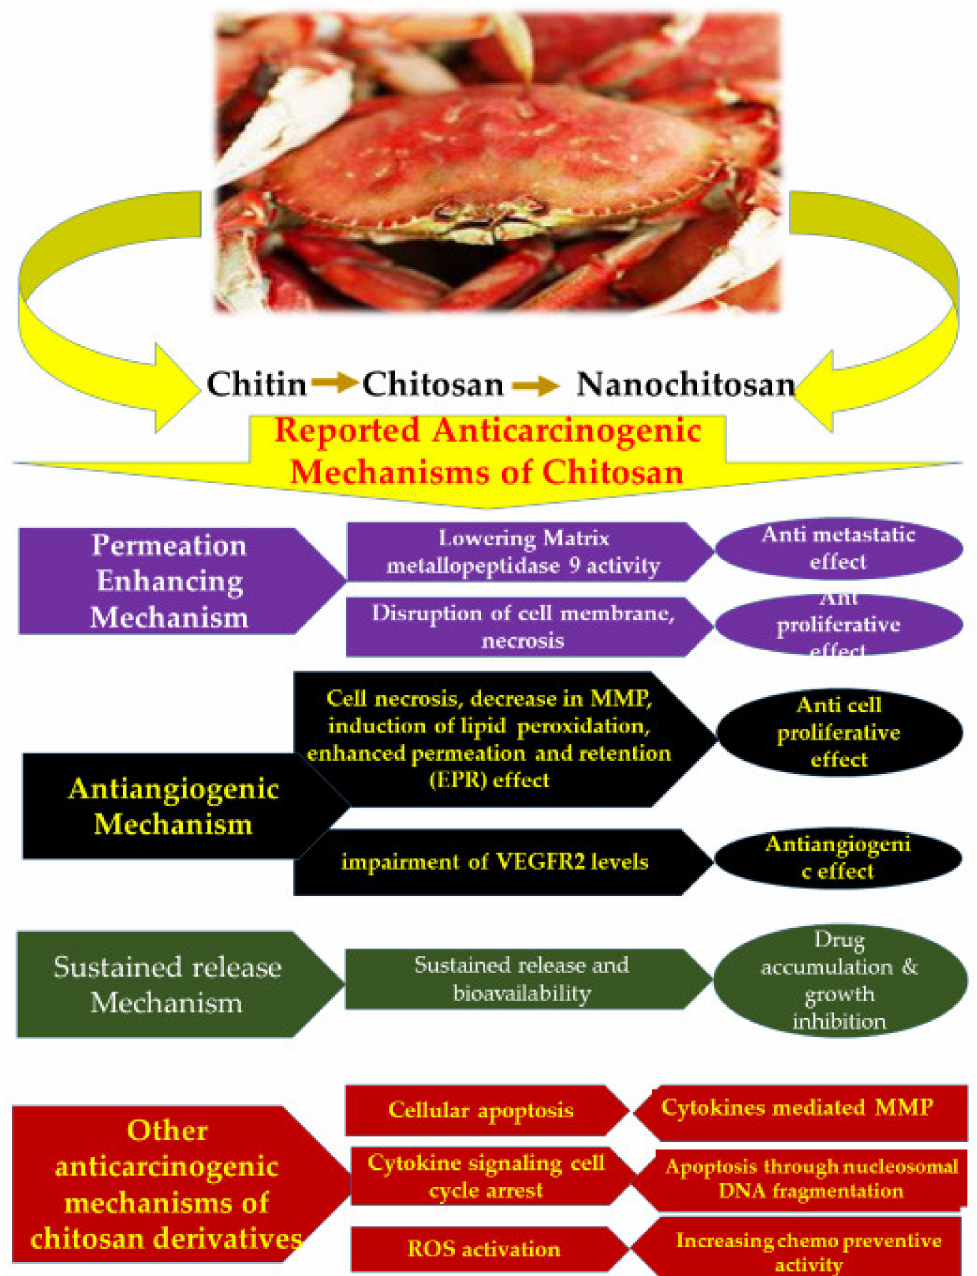
Figure 2. Overview of the anticarcinogenic mechanisms of chitosan and its forms that have been reported in